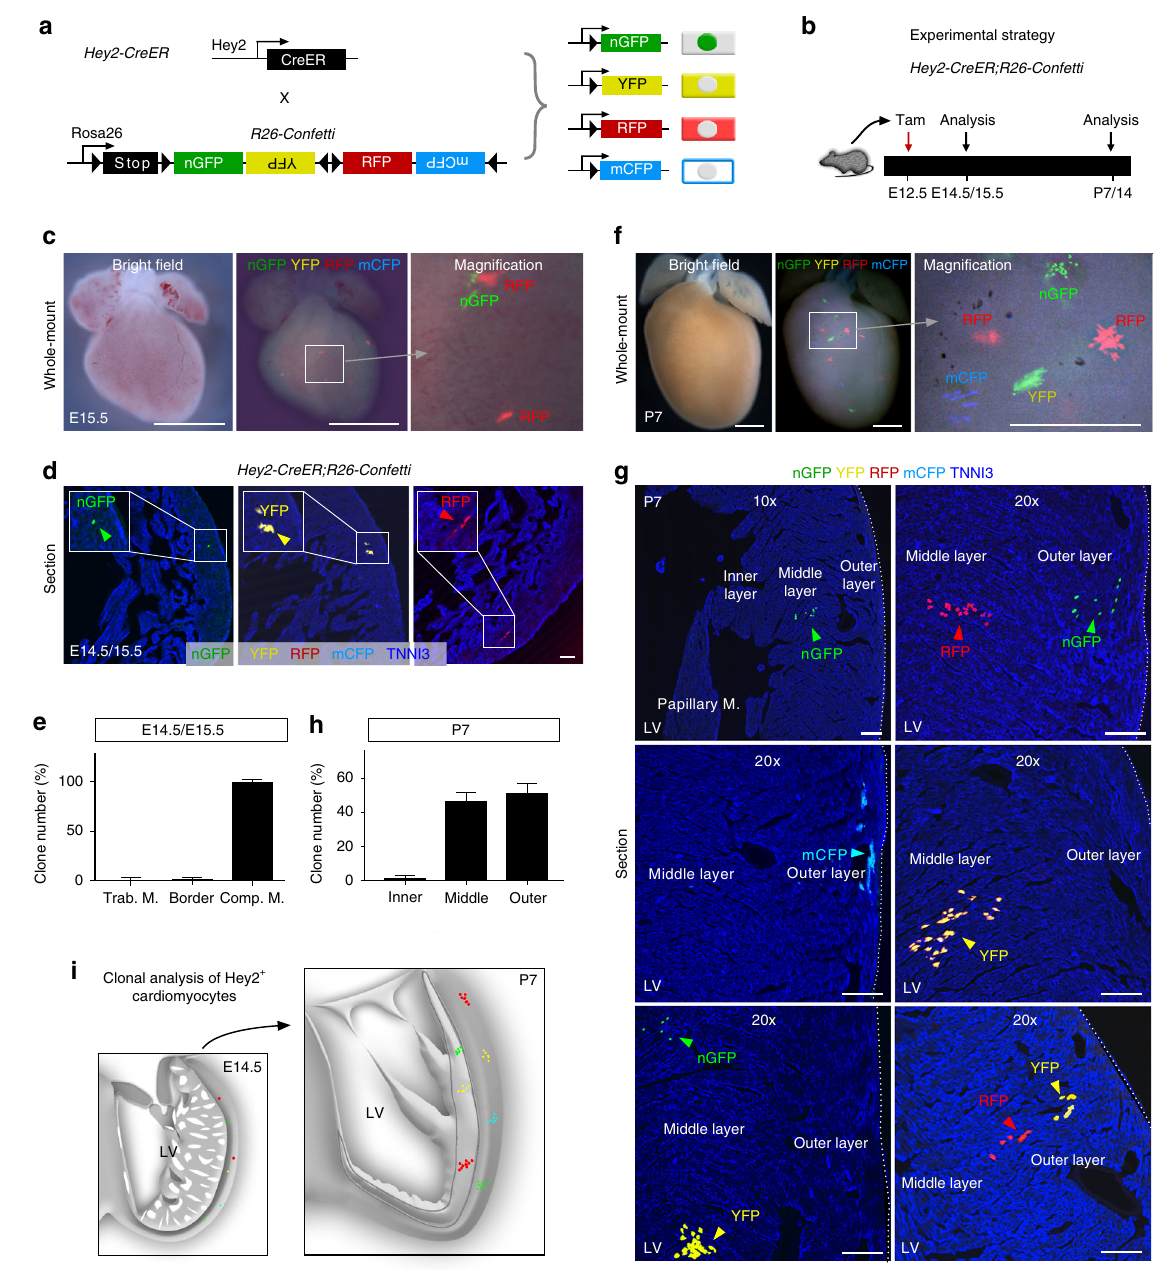
Fig. 8 Clonal analysis of single Hey2 + cardiomyocyte from fetal to postnatal stage. a Schematic fi gure showing four alternative recombination results (nGFP, YFP, RFP, and mCFP) by crossing Hey2-CreER with R26-Confetti line. b Schematic fi gure showing experimental strategy. c , f Whole-mount fl uorescence view of E15.5 and P7 Hey2-CreER;R26-Confetti hearts. d , g Sectional view of clones in E14.5/E15.5 and P7 Hey2-CreER; R26-Confetti heart sections. Arrowheads indicate single color colonies. Dotted lines in g indicate epicardium. e , h Quanti fi cation of the percentage of clone numbers in the inner, middle, and outer layer in each heart. n = 18 for E14.5/E15.5; n = 51 for P7. i Cartoon image showing sparse labeling of Hey2 + cells at embryonic stage and their expansion and contribution to the middle and outer myocardium layer of postnatal heart. Scale bars, 1 mm in c , f ; 100 µ m in d ,